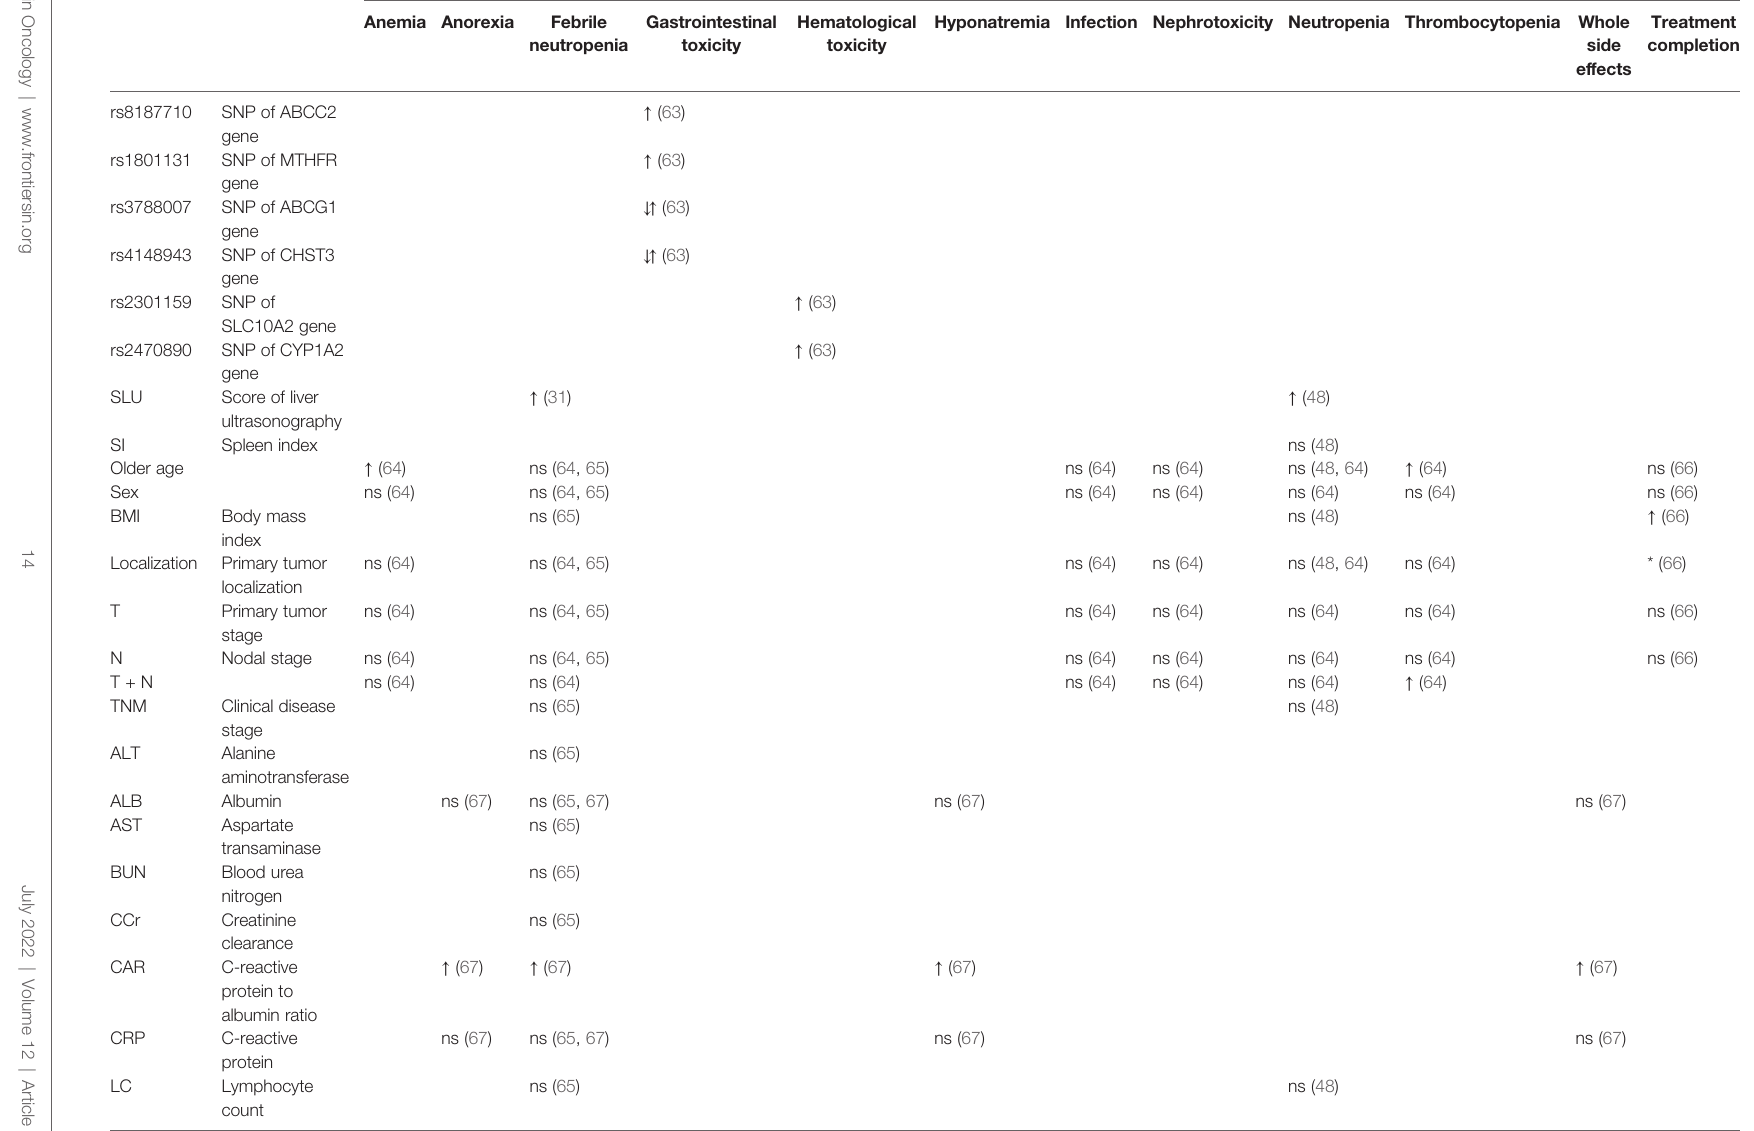
TABLE 5 | Summary of predictive factor for iCHT